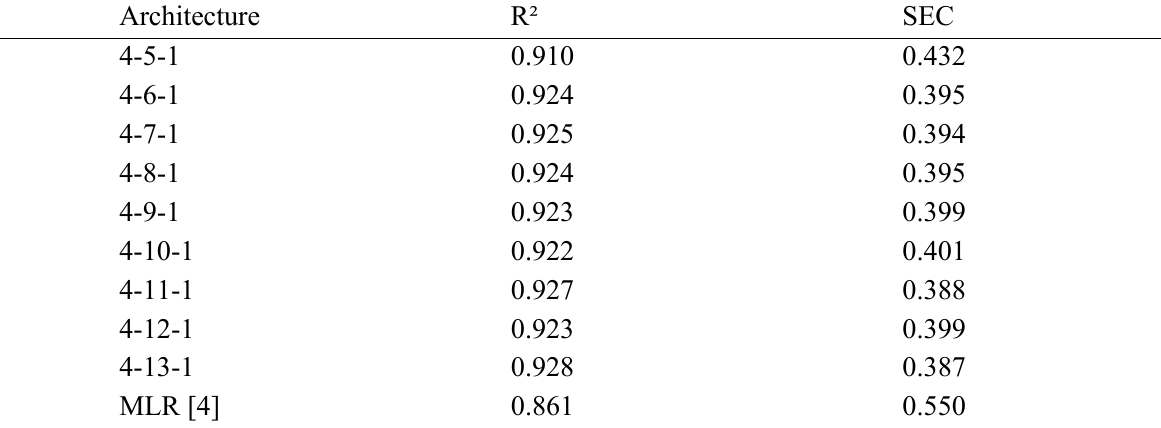
Table 1 . Standard error of computation (SEC) and correlation coefficient (R²) obtained by NN trained with 82 data